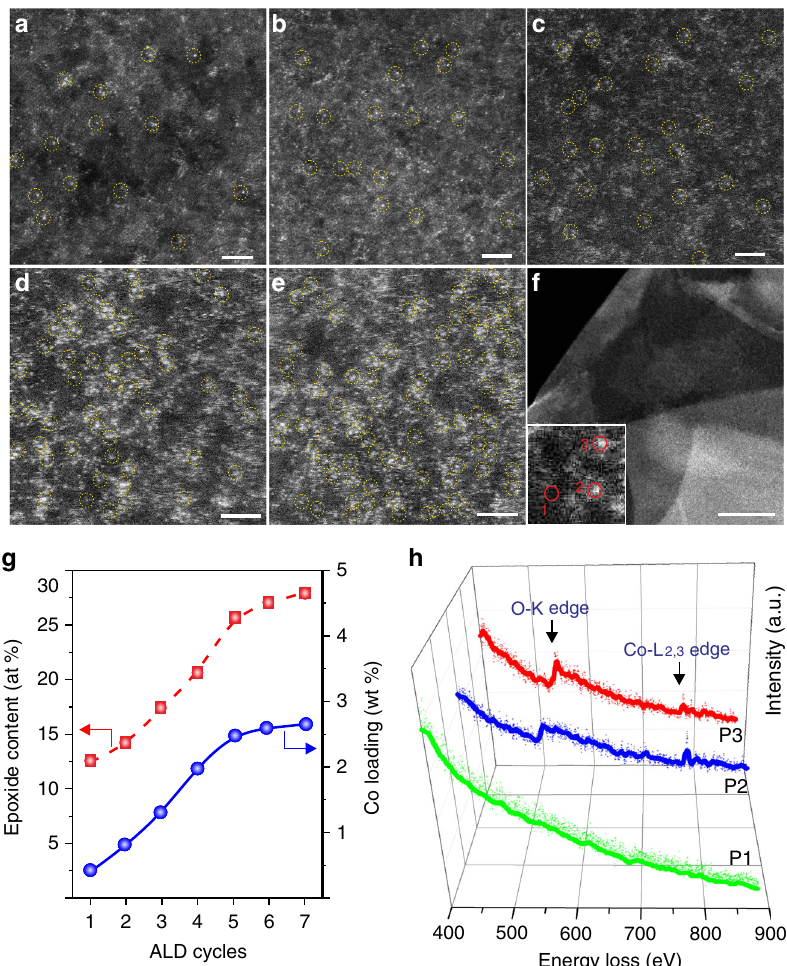
Fig. 2 Structural characterization and identi fi cation of Co 1 /G SACs. Aberration-corrected STEM-ADF images of Co 1 /G-0.4 ( a ), Co 1 /G-0.8 ( b ), Co 1 /G-1.3 ( c ), Co 1 /G-2.0 ( d ), and Co 1 /G-2.5 ( e ). Scale bars, 2 nm ( a – e ), 50 nm ( f ). Co 1 single atoms are highlighted by yellow dashed circles. f The STEM-ADF image of Co 1 /G-2.5 catalysts at low magni fi cation. g The evolution of epoxy content in graphene and Co loadings of Co 1 /G SACs catalysts as a function of the number of ALD cycles. h EEL spectra of O K-edge and Co L 2,3 -edge acquired in the bare graphene region (position 1 as marked in the inset of f ) and the isolated Co atom sites (Position 2, 3 as marked in the inset of f